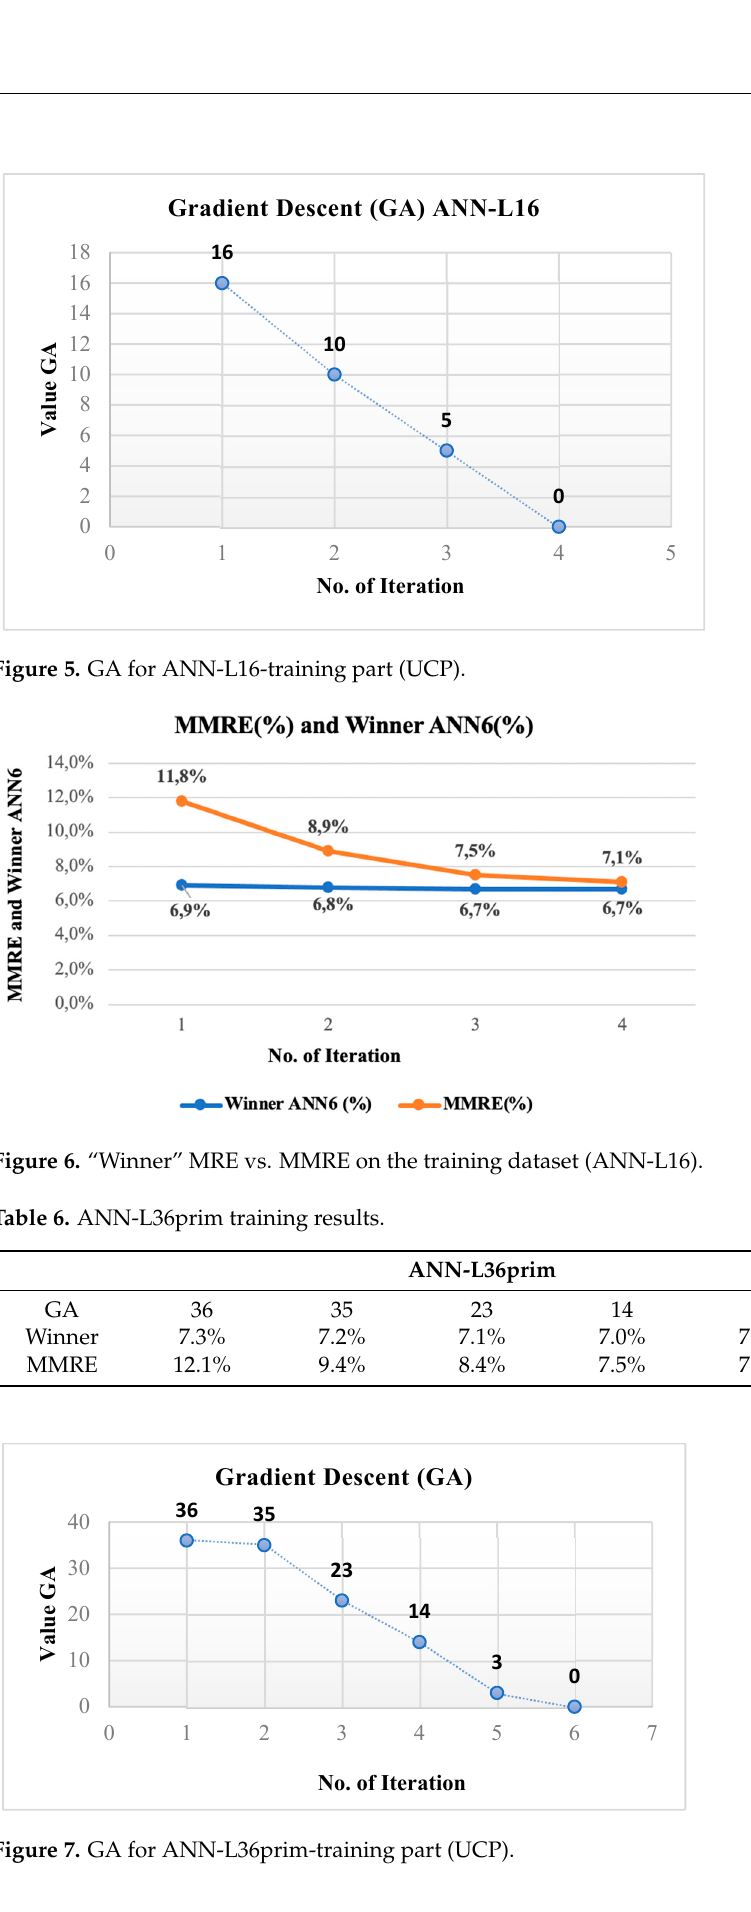
Figure 8. “Winner“ MRE vs. MMRE on the training dataset (ANN-L36prim). The obtained results for the two proposed architectures, ANN-L16 and ANN-L36, in all three parts of the experiment showed that the different nature of the data set does not affect the complexity of the architecture used. That is, it does not depend on the value of the input values. In the first proposed architecture, ANN-L16, all six input values were used (where four are linearly independent and two linearly dependent), and the MMRE value in all three parts of the experiment is 7.5% of Table 7. Using the second architecture, ANN-L36prim, with four independent input values, the same MMRE value, of 7.5%, was obtained in all three parts of the experiment (Table 7). The error differences in individual parts of the experiment are not more than 0.5%, indicating the proposed model’s reliabil- ity. Table 7. MMRE value in all three parts of the experiment (UCP). Datasets